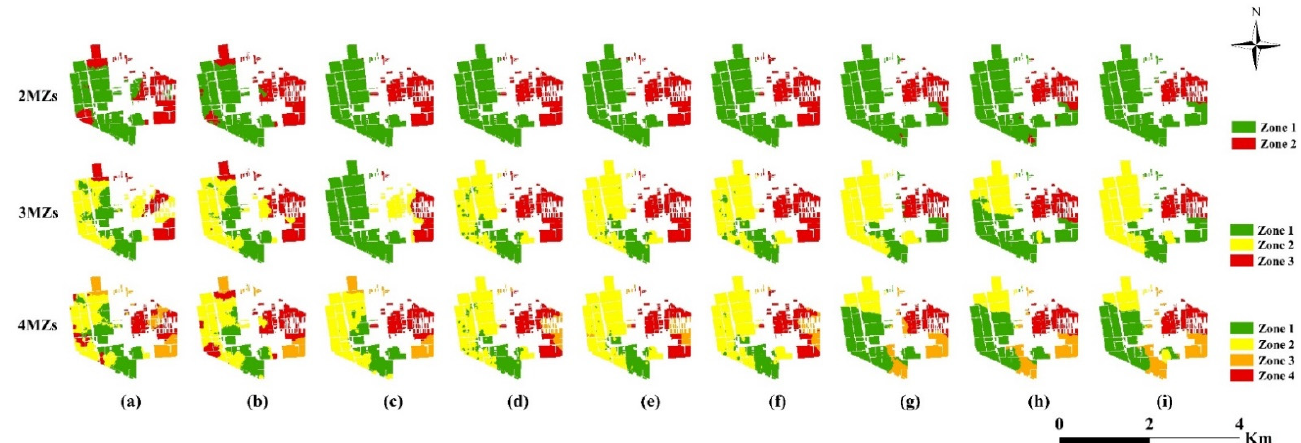
Figure 5. Maps of the MZs defined with the application of nine clustering algorithms. ( a )